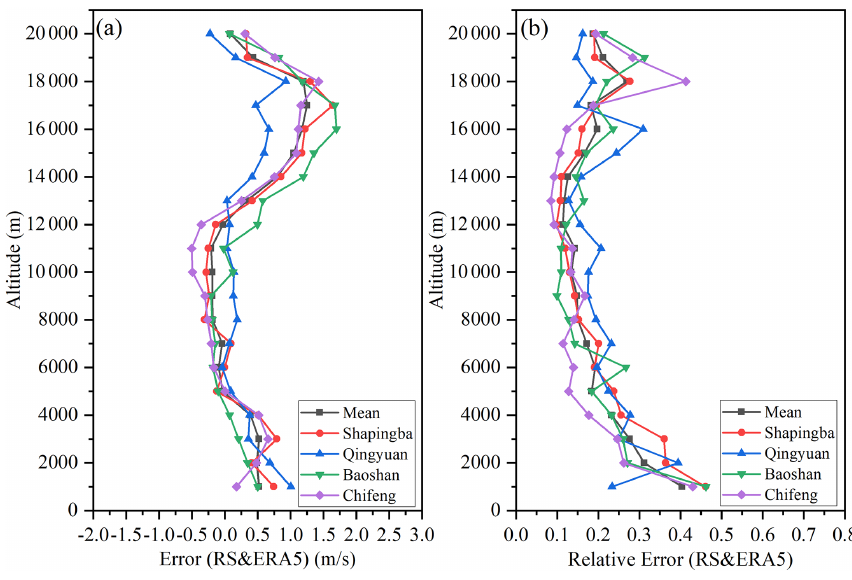
Figure 6. Vertical comparison of ERA5 and RS wind data for four regions. (a) Error and (b) relative error. Table 4. Comparison results of Aeolus and L-band RS in different regions. Chifeng Baoshan Shapingba Mie-cloudy Rayleigh-clear Mie-cloudy Rayleigh-clear Mie-cloudy Rayleigh-clear Mie-cloudy Rayleigh-clear